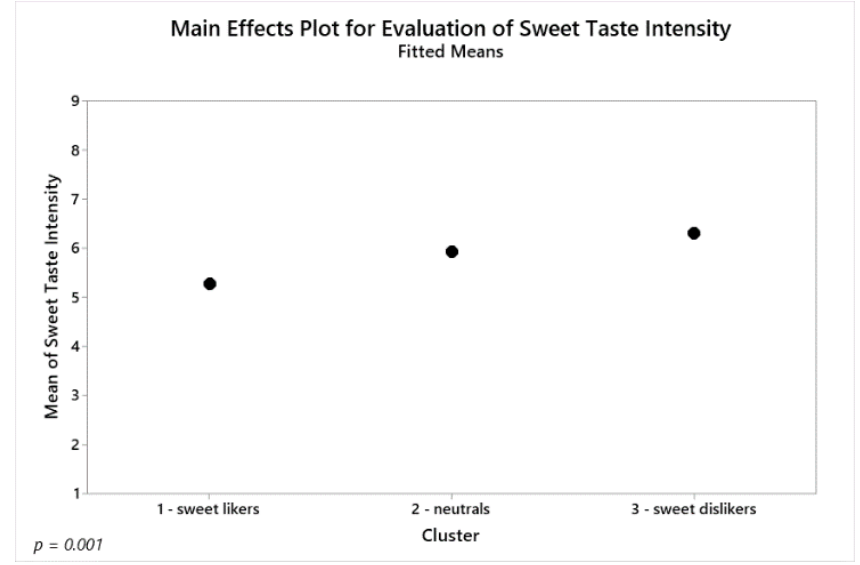
Figure 3. Fitted means of rated sweet taste intensity for the three clusters found in the consumer study.